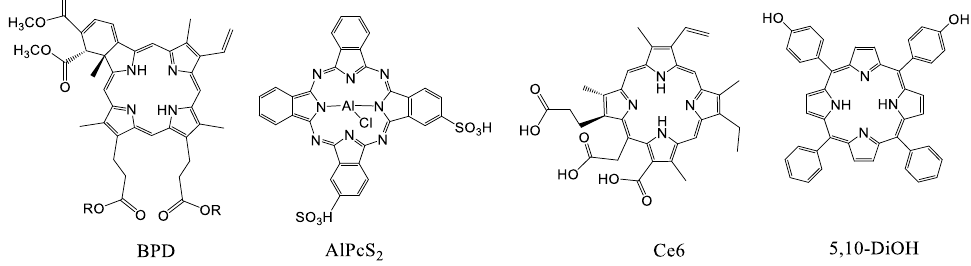
Figure 9. Chemical structures of porphyrins (BPD, AlPcS 2 , Ce6 and 5,10-DiOH). The photosensitizer sinoporphyrin sodium (DVDMS) and PTX were entrapped into the lipid membrane and aqueous core of liposomes prepared from DPPC, 1,2-distearoyl- sn-glycero-phosphoethanolamine-N-[methoxy(polyethyleneglycol)-2000] (DSPE-PEG